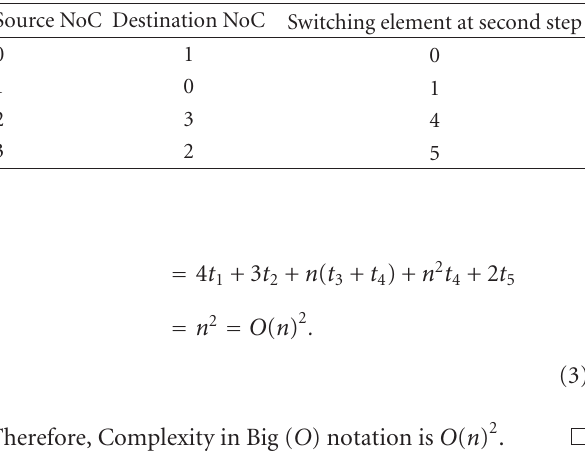
Table 15: Intermediate SE information while data moves from source NoC to destination NoC at second step of best